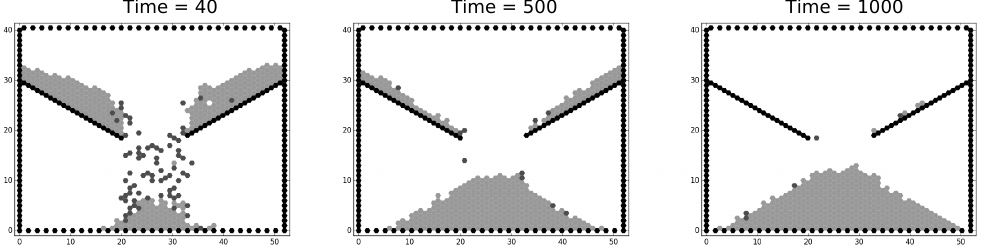
Figure 6. Lattice grain simulation of emptying of a silo. Light-shaded grains are stationary; darker-shaded ones are in motion. Black cells are walls (rock). Time units are indicated in seconds. From Tucker et al. (2016).